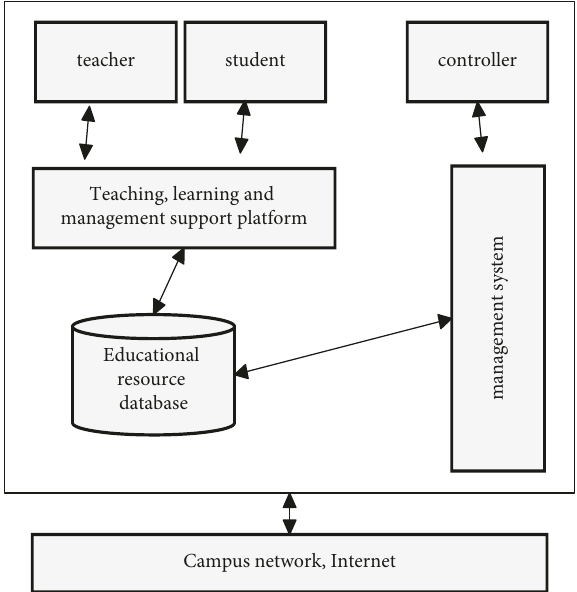
Figure 3: The architecture of university sports network education resources.